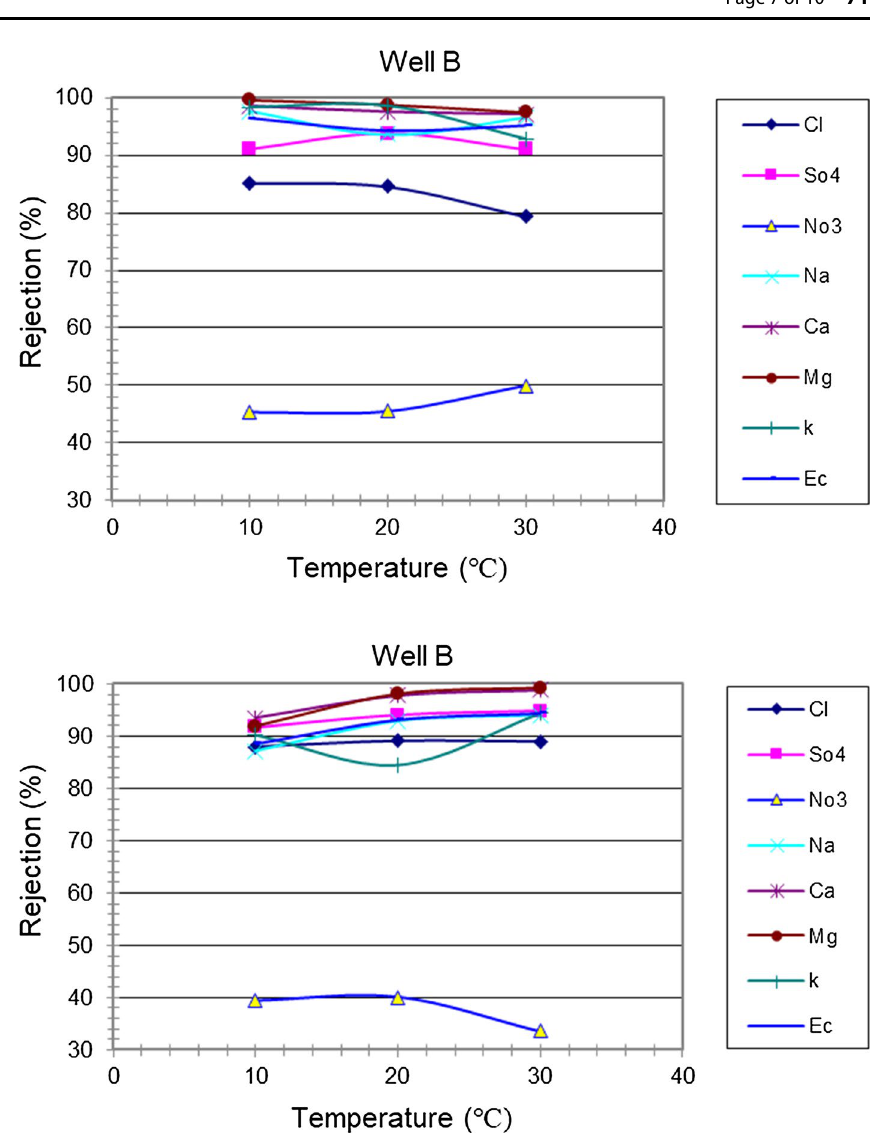
Fig. 9 Rejection rate of ions versus temperature (pressure: 8 bar)